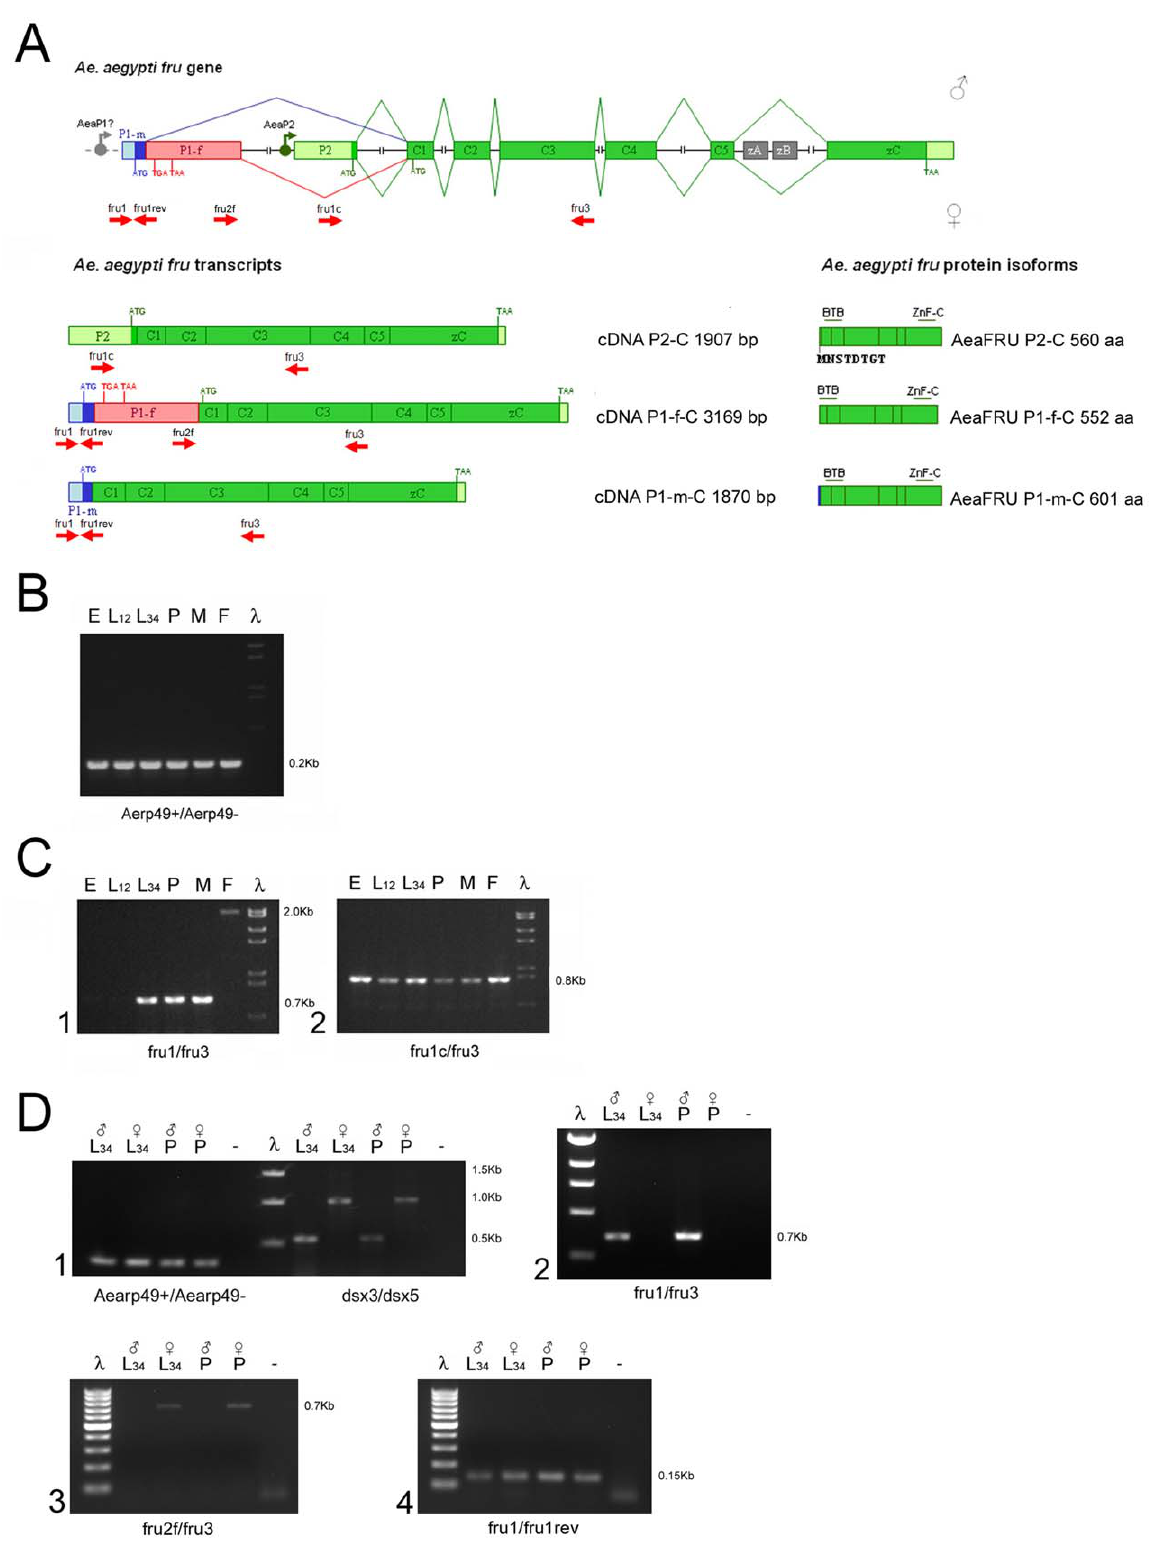
Figure 5. Developmental expression analysis of the Aeafru gene. (A) Aeafru gene, transcripts and protein isoforms. Transcripts derived from a putative AeaP1 promoter consist of seven exons with six introns and are alternatively spliced. The transcripts derived from promoter AaeP2 consist of seven exons and six introns and share with AaeP1 ones the common exons C1-C2-C3-C4-C5 and the zinc-finger exon zC but have the upstream exon P2 with and an alternative ATG signal which use led to the translation of AeaFRU P2-C isoform. The translation of all isolated Aeafru -C isoforms terminates in both sexes at the stop codon (TAA) in the zinc-finger exon zC. Primers used in the following amplifications are indicated as short red